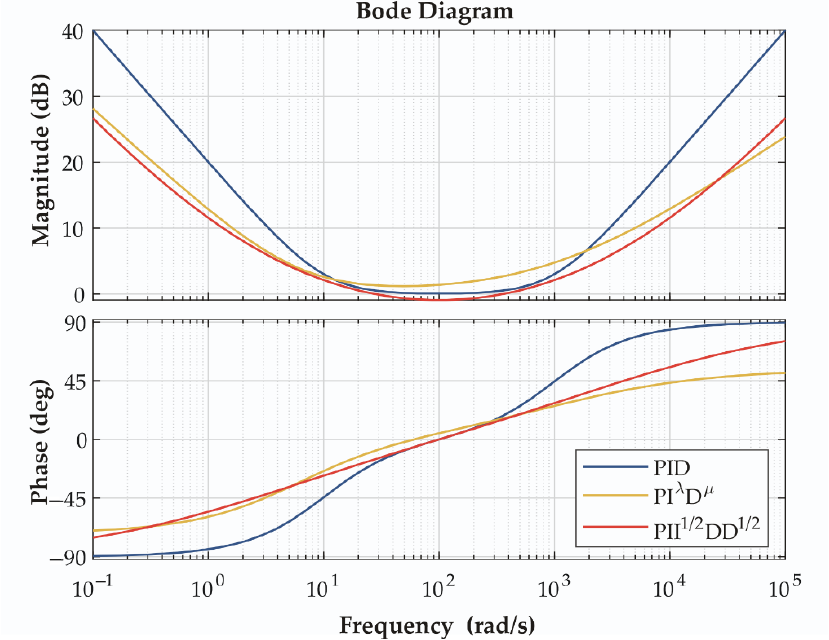
Figure 2. Example frequency responses of PID (blue), PI λ D μ (yellow) and PII 1/2 DD 1/2 (red) control- lers.